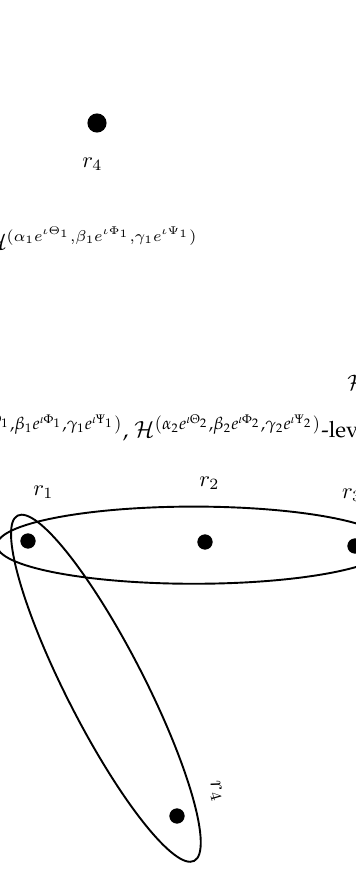
( α 3 e ι Θ 3 , β 3 e ι Φ 3 , γ 3 e ι Ψ 3 ) -level hypergraph. Figure 4. H